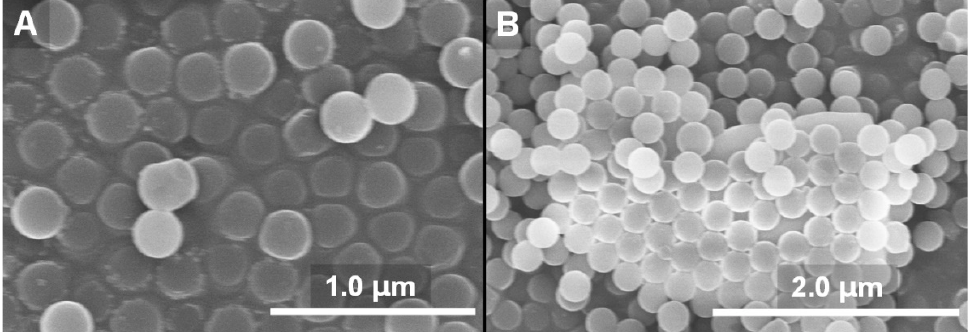
Figure 2. Comparison of SEM images of samples prepared by one-pot method and spray-coating method: ( A ) dried film of PVA/PS homogeneous solution; ( B ) PS CPC template prepared by spray- coating. Both samples were prepared with 252 nm PS nano-colloids.